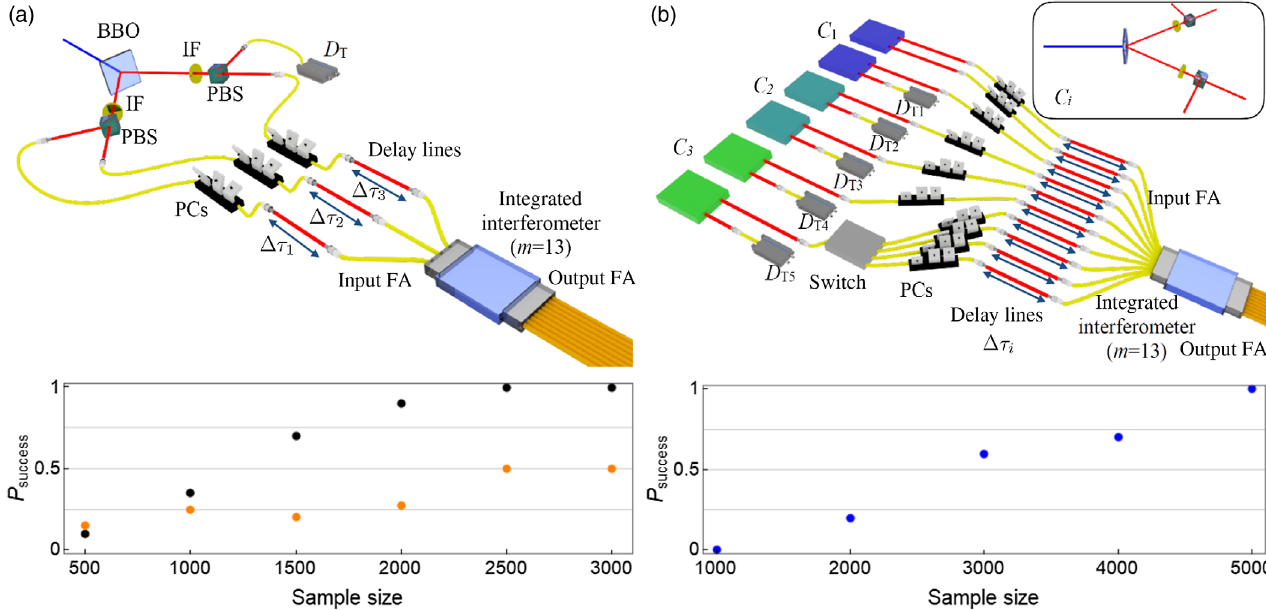
FIG. 4. Experimental validation of boson-sampling experiments. Experimental setups for an n ¼ 3 standard (a) and scatter-shot (b) boson-sampling experiments in an integrated m ¼ 13 interferometer (see Supplemental Material [53]). Bottom insets: The corresponding success probabilities of the compatibility test between inputs with indistinguishable and distinguishable photons for different sample sizes. (a) Black and orange dots refer, respectively, to K means++ with majority voting and bubble clustering. The discrepancy from the numerical results in Table III is due to the nonideal indistinguishability of the injected photons [60]. (b) Input states are generated probabilistically by six independent parametric down-conversion sources (represented as boxes) in three different BBO crystals C i (see the inset). Experimental data correspond to eight different inputs. The number of events for all input states randomly varies for each sample size drawn from the complete data set. The clustering algorithm is K means, initialized by K means++, with majority voting. In both panels: BBO, beta barium borate crystal; IF, interferential filter; PBS, polarizing beam splitter; PC, polarization controller; FA, fiber array. Tests are performed with a significance level of 5% and using d ¼ L 2